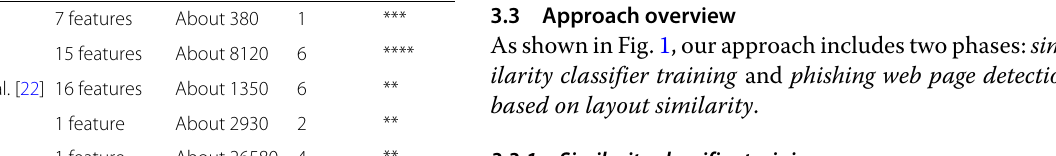
Table 1 Comparison of learning-based phishing detection